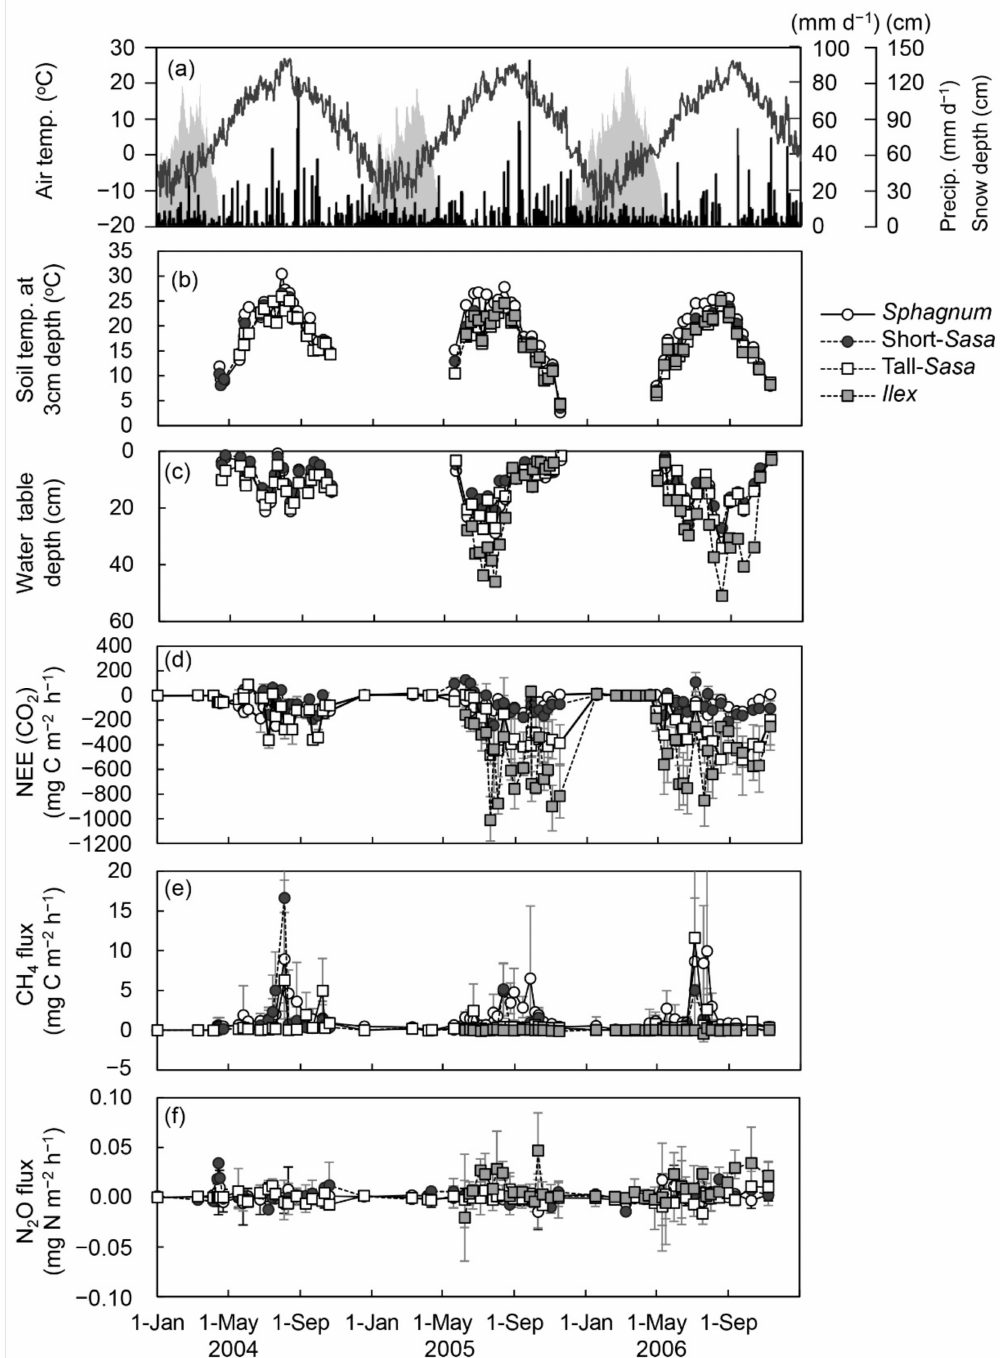
Figure 3. Seasonal changes in daily air temperature, precipitation and snow depth (( a ) line, black and grey bars, respectively), soil temperature at 3 cm depth ( b ), water table depth ( c ), Net Ecosystem Exchange (NEE) ( d ) and CH 4 ( e ) and N 2 O ( f ) fluxes. Error bars indicate minimum and maximum value. Positive fluxes indicate net emissions to the atmosphere and negative fluxes indicate net uptake from the